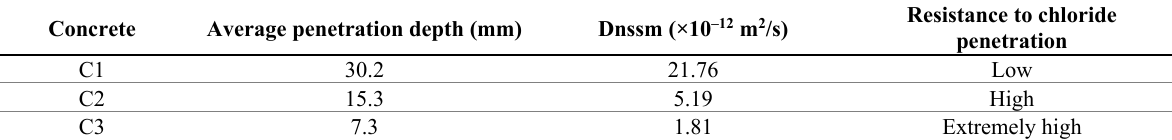
Table 9. Concretes non-steady-state migration coefficient